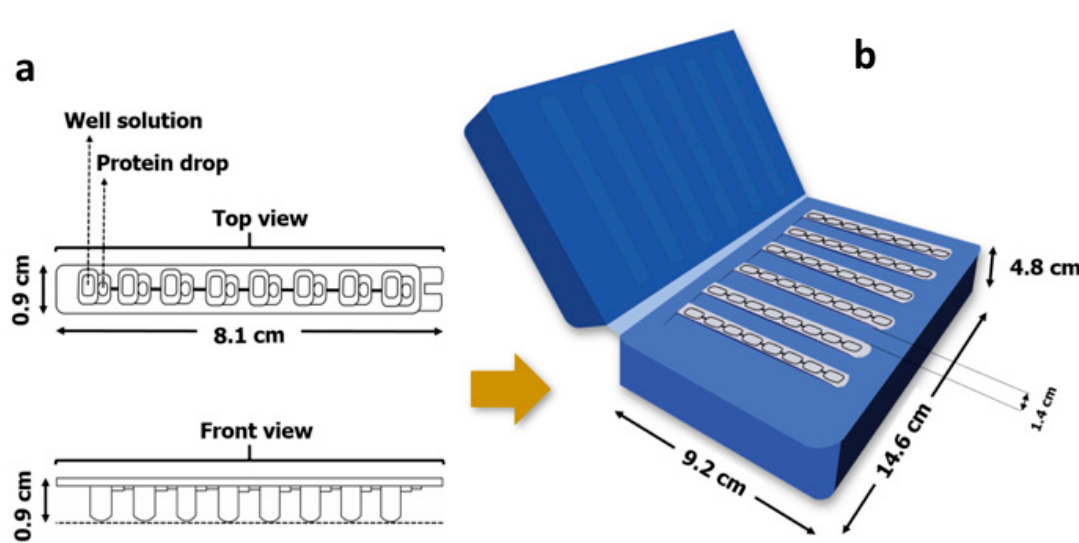
Figure 2. This shows the dimensions and experimental details of the ( a ) top and front view of the plastic disposable inserts used in the TG40 apparatus and ( b ) the general overview and dimensions of the thermal protection device.